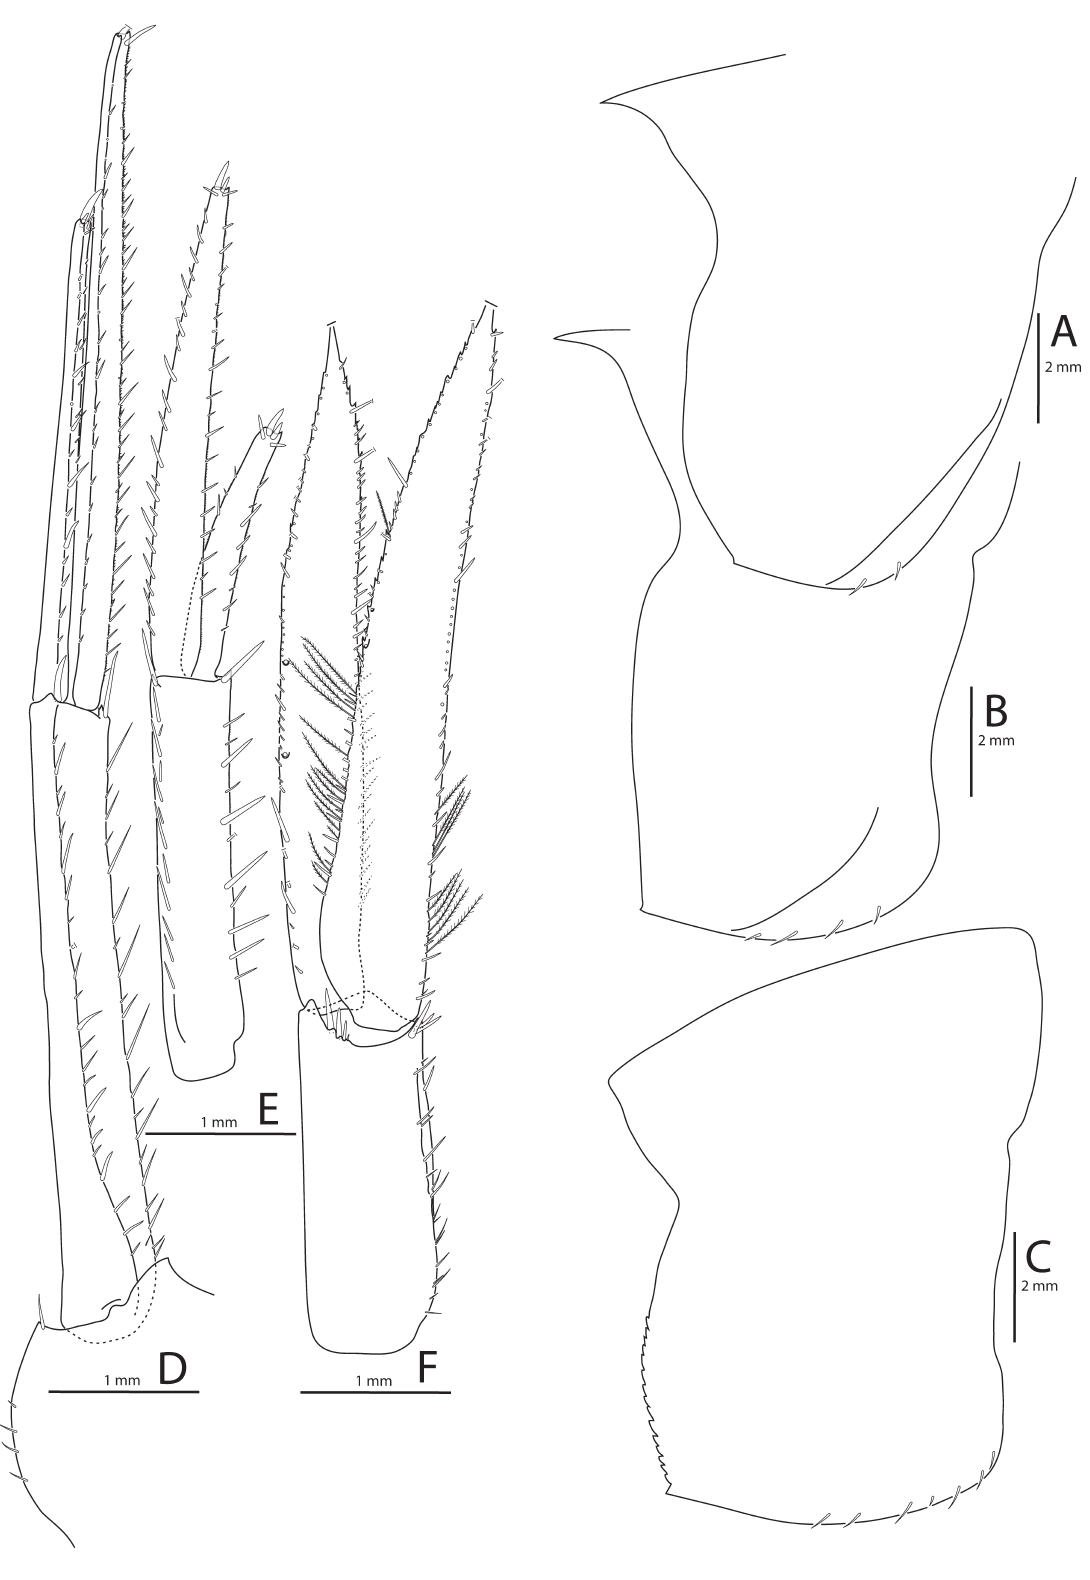
Fig. 7. Halirages cainae sp. nov., holotype ♂, 40 mm, Norwegian Sea, MAREANO 2009-111, R-station 487, sample 157. A . pleonite 1. B . pleonite 2. C . pleonite 3. D . ventrolateral part of urosomite 1 and right U1 (apical cluster of spines of outer ramus drawn after left U1). E . left U2. F . right